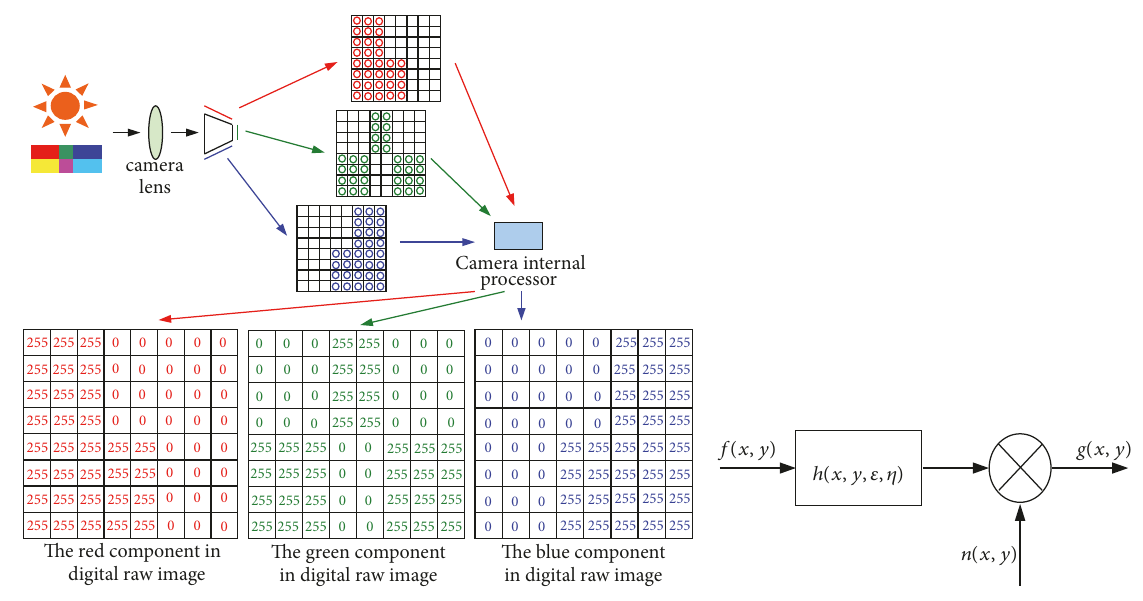
Figure 1: Imaging process and image degraded